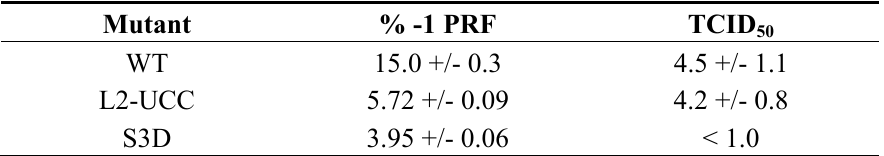
Table 1. Frameshifting efficiency affects infectivity. SARS coronavirus mutants are indicated. -1 PRF efficiencies and standard error as measured in VeroE6 cells as described in the Experimental Section. The data for the WT and L2-UCC viruses has previously been published [7,19]. TCID values were calculated as described in the Experimental Section. 50 The error is the standard deviation of six